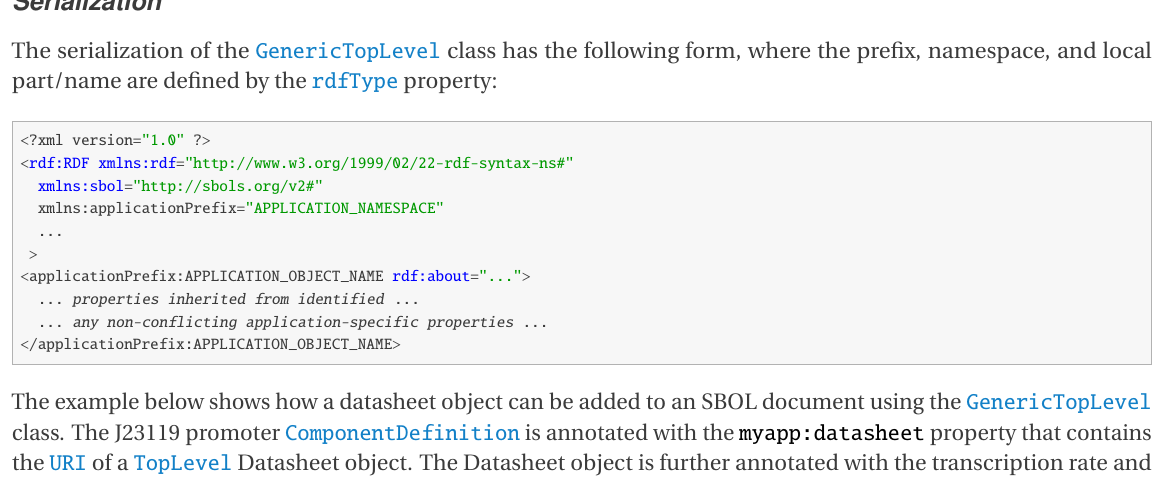
Figure 25: Diagram of the GenericTopLevel class and its associated properties, which is used for embedding externally defined entities into SBOL documents.